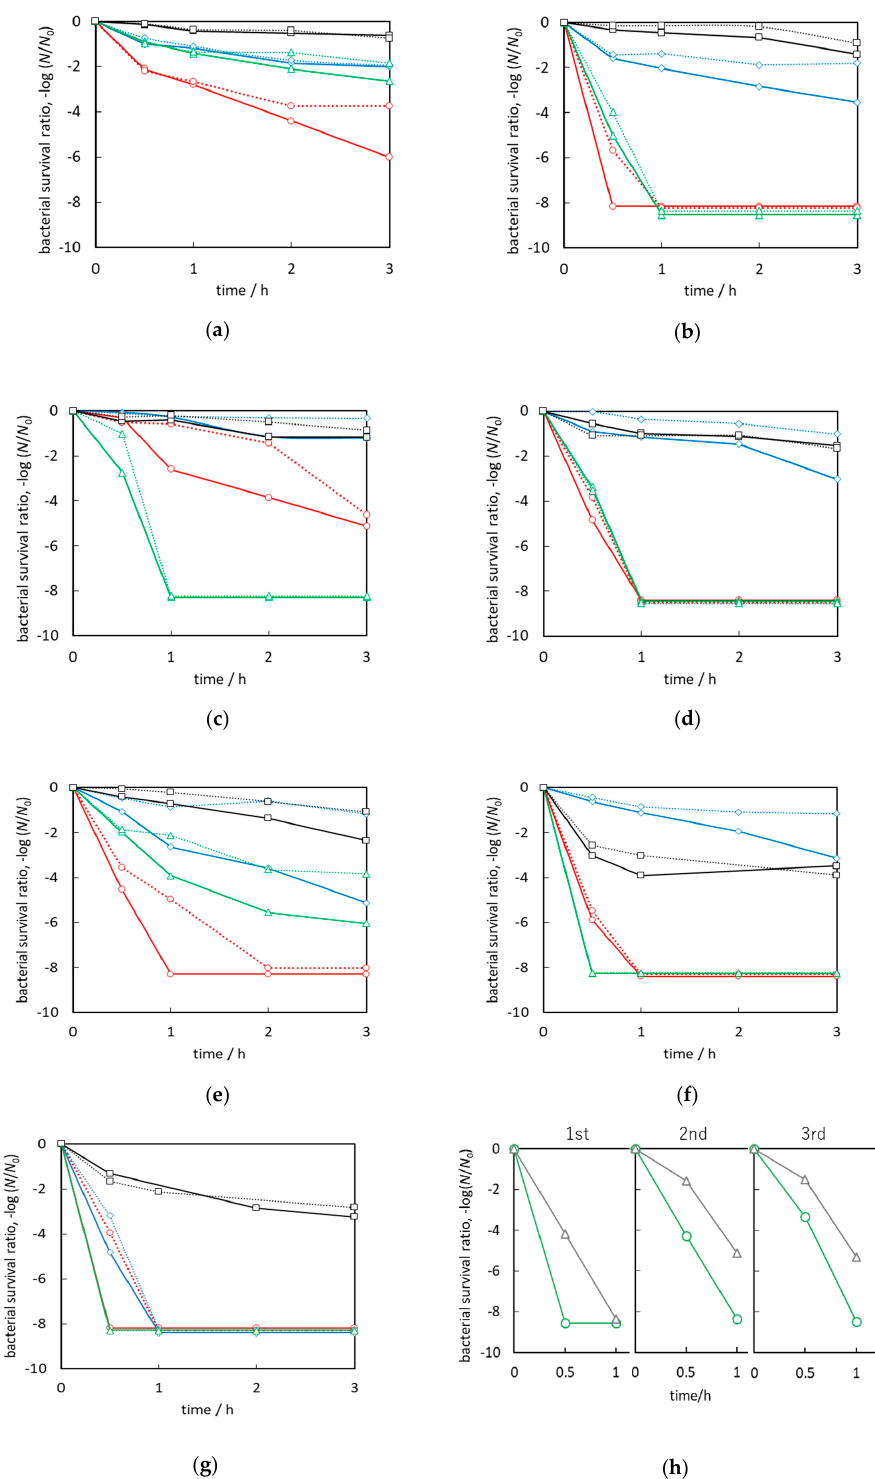
Figure 6. Bactericidal activities of bare and copper modified titania: ( a ) ST-01, ( b ) FP6, ( c ) P25, ( d ) ST-41, ( e ) TIO-6, ( f ) ST-G1 and ( g ) TIO-5 (black: bare, red: m-1h, blue: w-1h, green: m-5h) under visible light (solid line) and in the dark (dashed line); ( h ) the activity of CuTIO-5m-1h photocatalyst during three successive experiments under vis irradiation (green) and in the dark (grey).